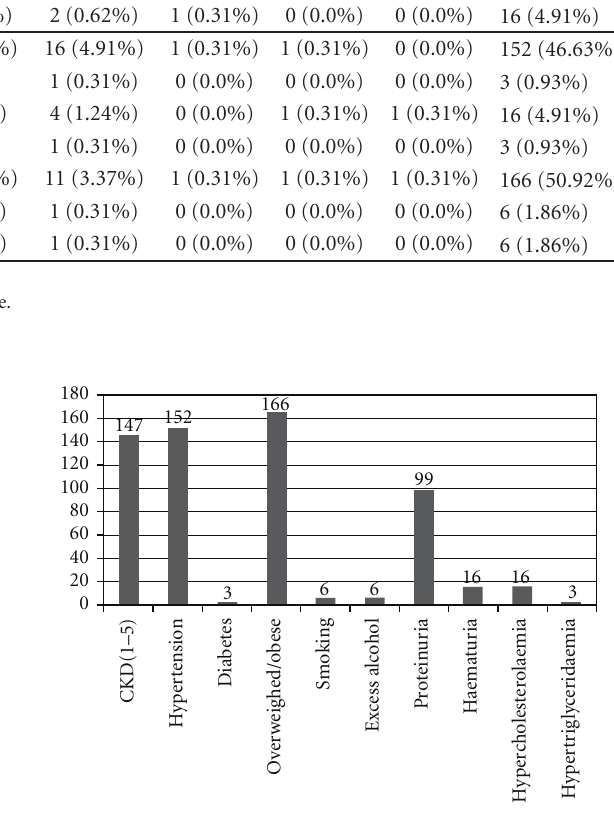
Figure 1: Frequencies of occurrence of CKD, urinary abnormalities and cardiovascular risk factors in the studied